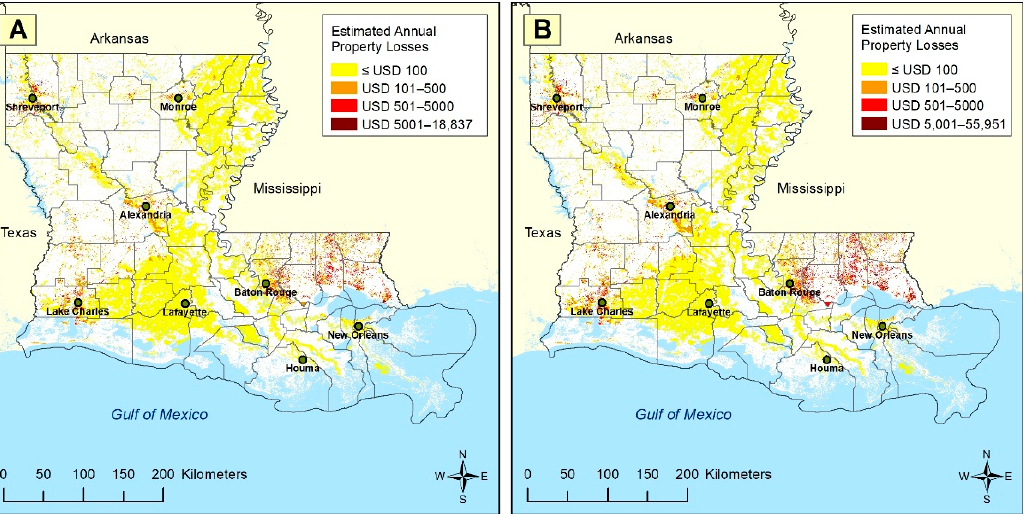
Figure 3. Estimated annual property loss (2010 USD) due to wildfire by census block: ( A ) historical (1992 − 2015) and ( B ) 2050.